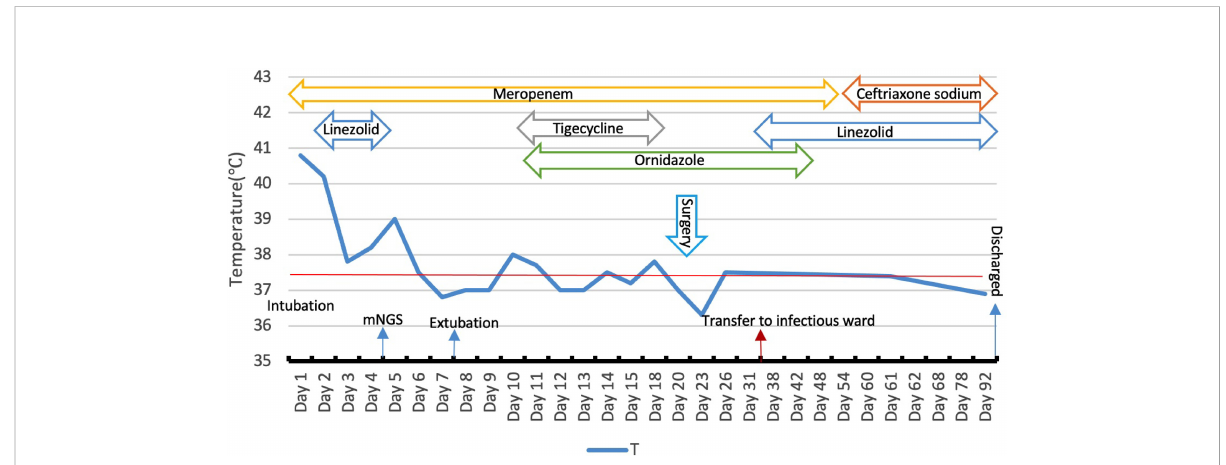
FIGURE 3 Body temperature and anti-infective treatment during hospitalization, meropenem 2.0 g q8h (day 1 – 55), linezolid 600mg q12h (day 2 – 5, day 36 – 92), tigecyclin 100mg q12h (day 10 – 15), ornidazole (day 13 – 54), ceftriaxone(day 56 – 92).